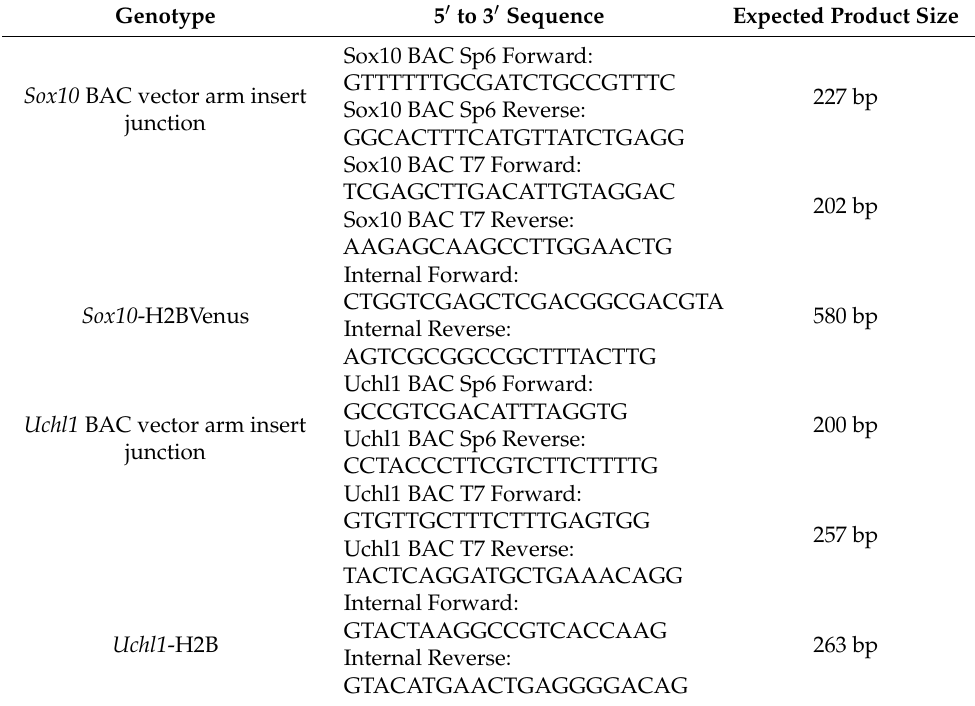
Table 2. Oligonucleotide primers used for genotyping mouse lines in this study.